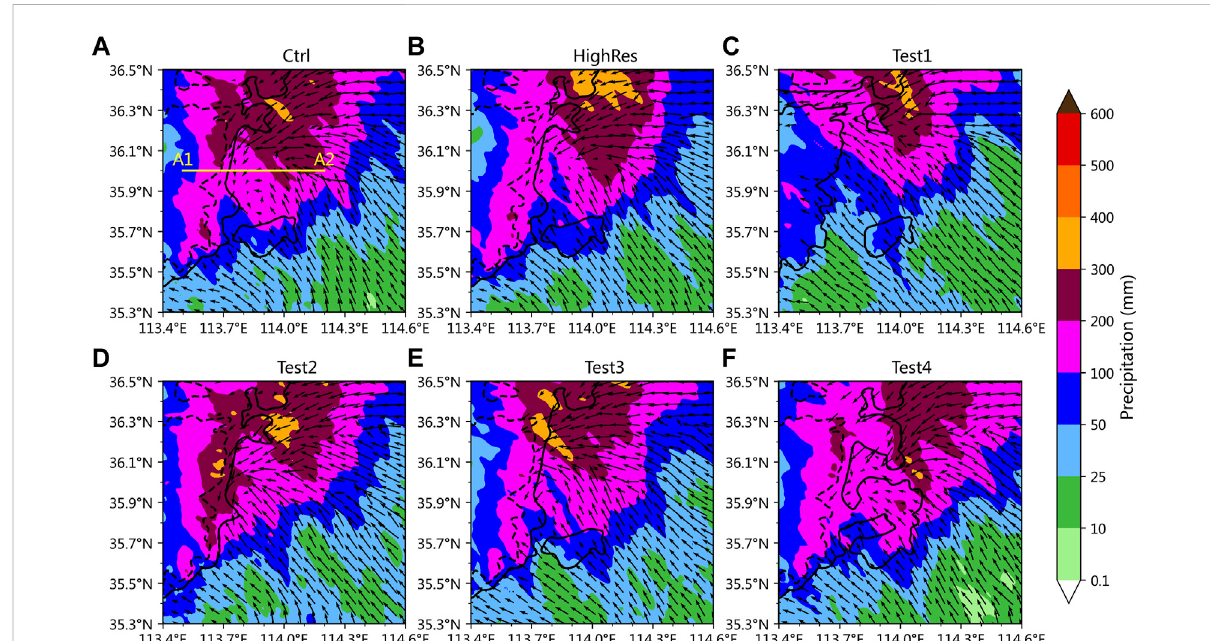
FIGURE 6 (A – F) Simulated precipitation by terrain sensitivity experiments from 0000 to 1200 UTC on 19 July 2016. The vector denotes the wind fi eld at 925 hPa at 0900 UTC on 19 July 2016, simulated by each sensitivity experiment. The black solid line denotes the 500 m contour line, and the black dotted line denotes the 1000 m contour